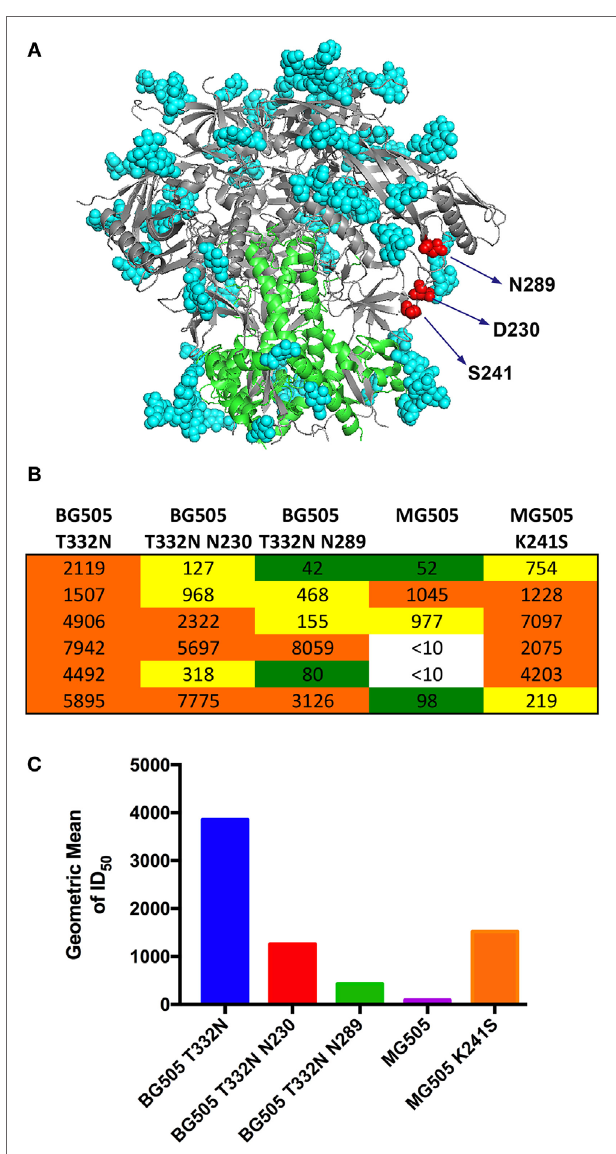
FigUre 5 | Antibodies elicited by BG505 NFL trimers target holes in the N-glycan shield. (a) Cartoon representation of the BG505 SOSIP trimer (PDB id 5CEZ) depicting known N-glycan holes at positions 289, 241, and 230, respectively. The backbone for gp120 is colored gray and gp41 is colored green. The amino acids at the position of the glycan holes are shown as red spheres and ordered glycans as seen in the crystal structure are shown as cyan spheres. (B) Neutralization ID 50 titers at the final bleed point (P4) against a panel of autologous tier 2 BG505 viruses that have the glycans restored at positions 230 and 289 are shown. Elicitation of antibodies against the glycan hole at position 241 was probed against the parent virus MG505 that lacks the glycan at position 241 and the MG505 K241S variant that restores a serine residue at position 241 as it exists in wild-type BG505 virus. (c) Geometric mean of neutralization ID 50 titers showing reduction in neutralization against a panel of pseudoviruses with N-glycans